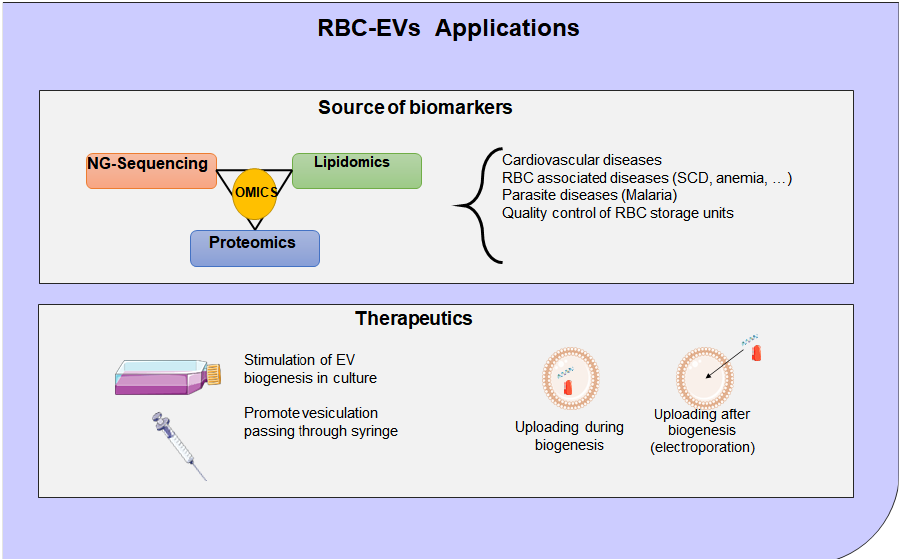
Figure 7. Schema represents the RBC-EVs applications. The biomarkers must be identified first using high-throughput technologies such as next generation sequencing or mass spectrometry. EVs can be collected from cells cultured in vitro, and nucleic acids may be incorporated by electroporation through incubation with the EVs. For therapeutics, cells are treated with a drug, or nucleic acids or proteins and introduced by chemical transfection.